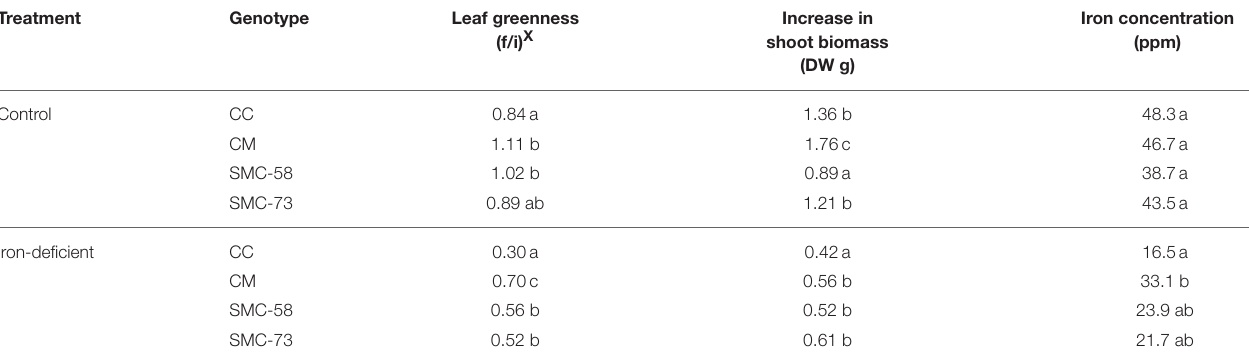
TABLE 9 | Leaf greenness (f:i), increase in shoot biomass (DW g) and iron concentration in shoot leaves (DW ppm) of Carrizo citrange (CC), C. macrophylla (CM) and the somatic hybrids SMC-58 and SMC-73 cultivated in greenhouse conditions for 10 weeks, either in control conditions (20 µ M Fe-EDDHA) or in iron-deficient conditions